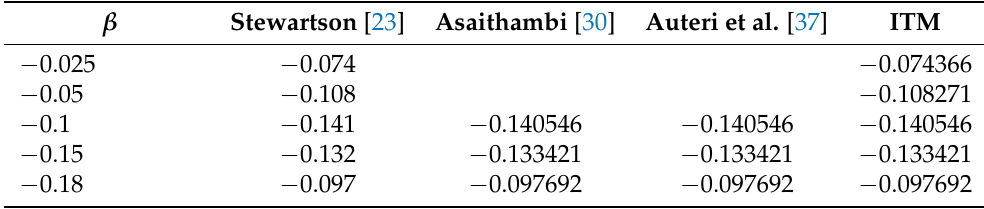
Table 4. Comparison for the reverse flow skin-friction coefficients = 15 and h ∗ = 25. The iterations were, from top to bottom line: 8, 7, 9, 7, and h ∗ 0 1